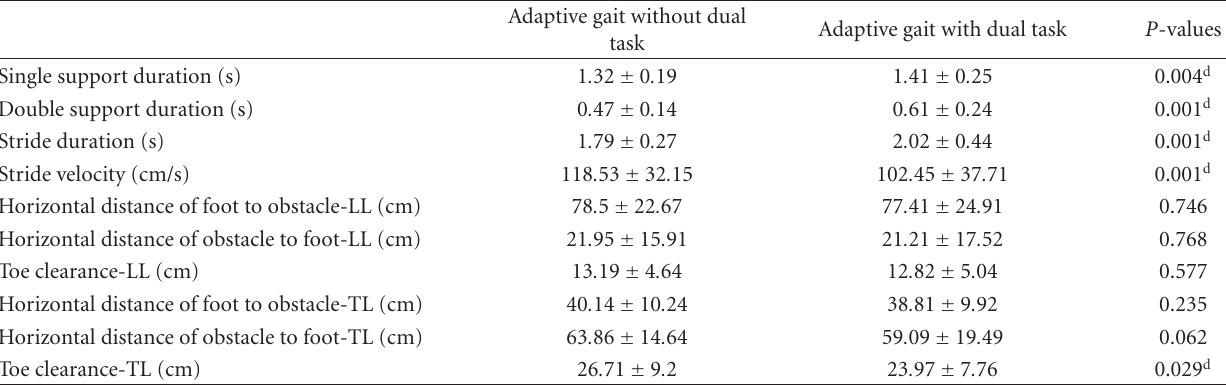
Table 2: Mean and standard deviation of the spatial-temporal parameters in the crossing